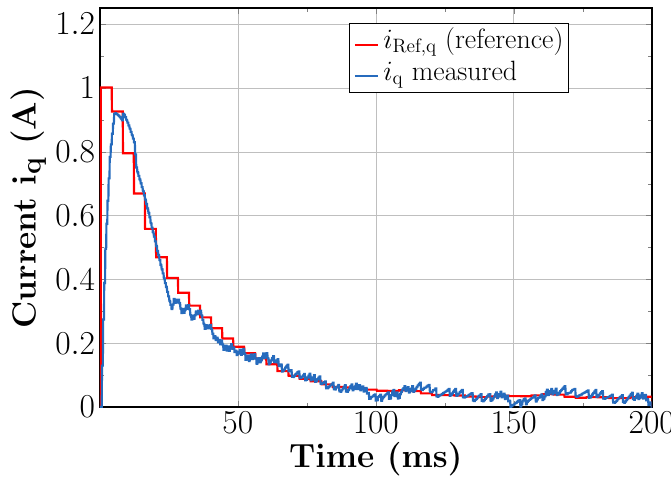
Figure 27. Sensorless speed control for 100 RPM, current on the